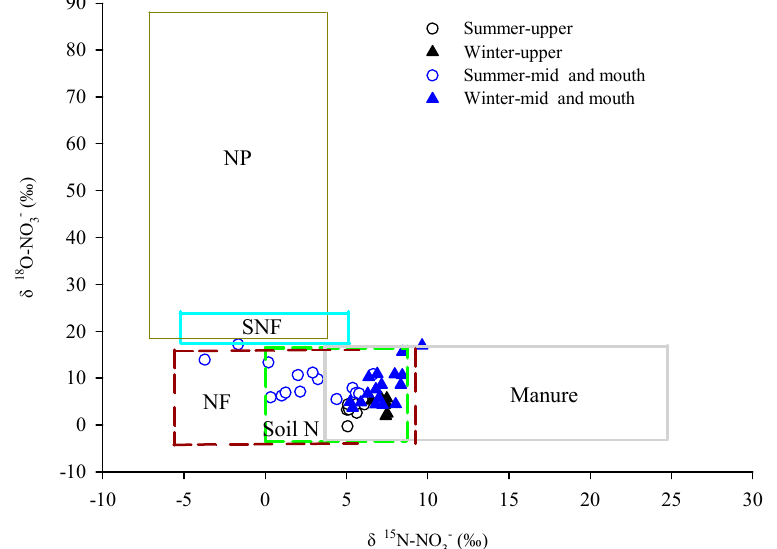
Figure 6. Values of δ 15 N-NO 3 − and δ 18 O-NO 3 − in seawater samples during different seasons in Zhanjiang Bay and various nitrate (NO 3 − ) sources (boxes). The five potential NO 3 − sources are manure, N fertilizer (NF), soil N [15], synthetic N fertilizer (SNF) [39], and N in precipitation (NP) from the northern area of the South China Sea [37]. The inset in the upper right corner shows an expanded view of δ 15 N-NO 3 − and δ 18 O-NO 3 − values in Zhanjiang Bay during different seasons. The regression was calculated from data for winter in the mid-bay and bay mouth.